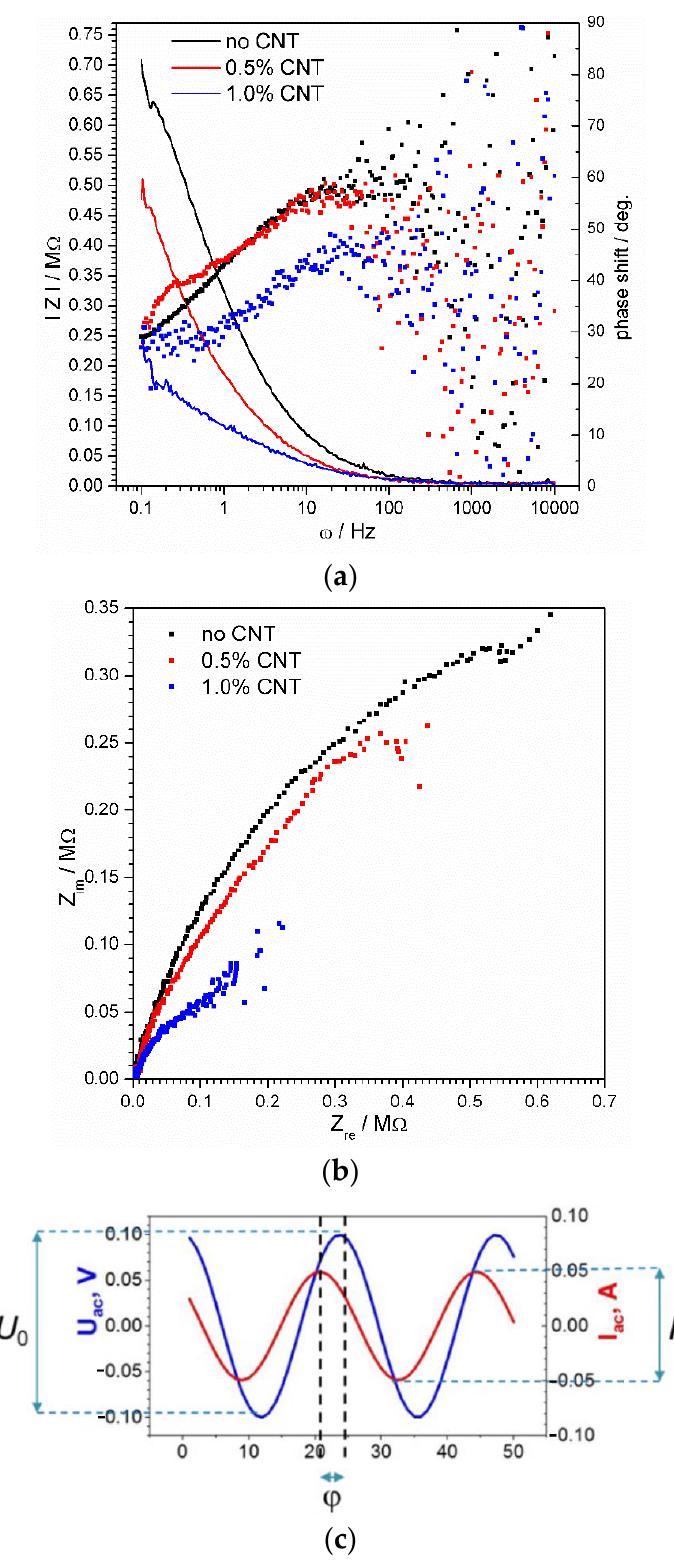
Figure 3. Bode ( a ) and Nyquist ( b ) spectra of geopolymer material modified with carbon nanotubes. Impedance module plot is shown by lines, while phase shift — by dots ( a ). A schematic illustration of the phase shift and amplitudes of the applied harmonic current signal and registered voltage response as functions of time ( c ).